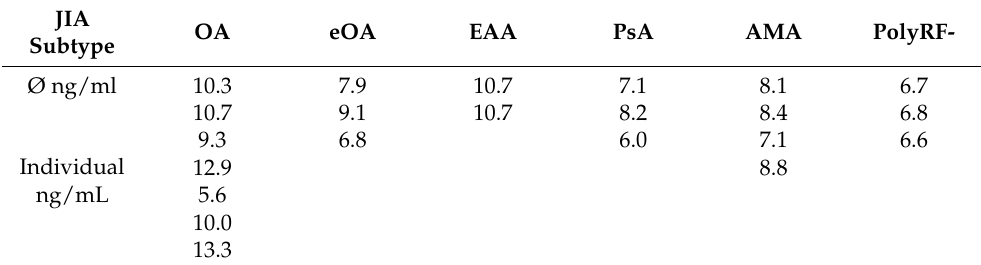
Table 3. GSN values in different subtypes of